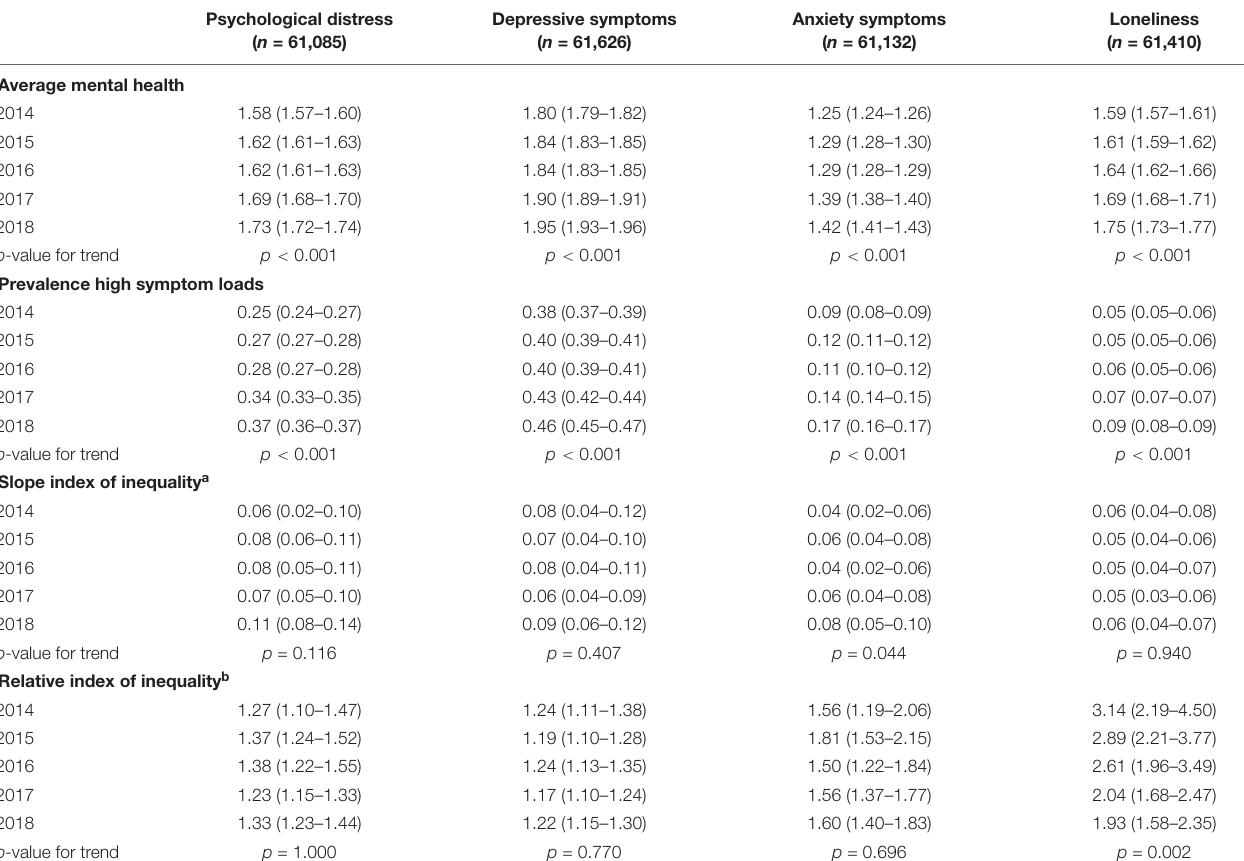
TABLE 3 | Average psychological distress, prevalence’s of high symptom load, absolute, and relative inequalities in mental health* among boys between 2014 and 2018 (five cycles) in the Ungdata survey. Psychological distress Depressive symptoms ( n = 61,085) ( n = 61,626)